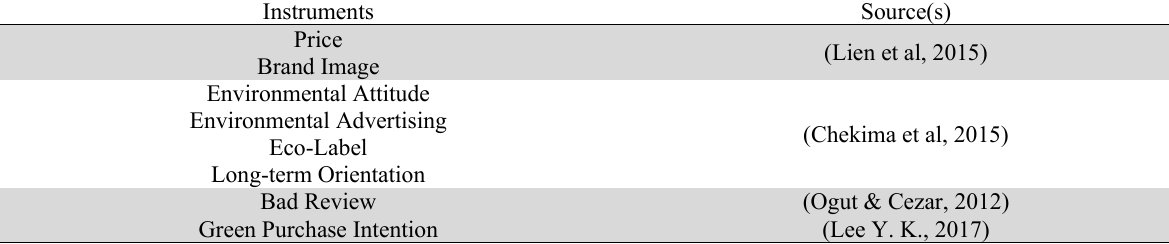
Source of Each Variables